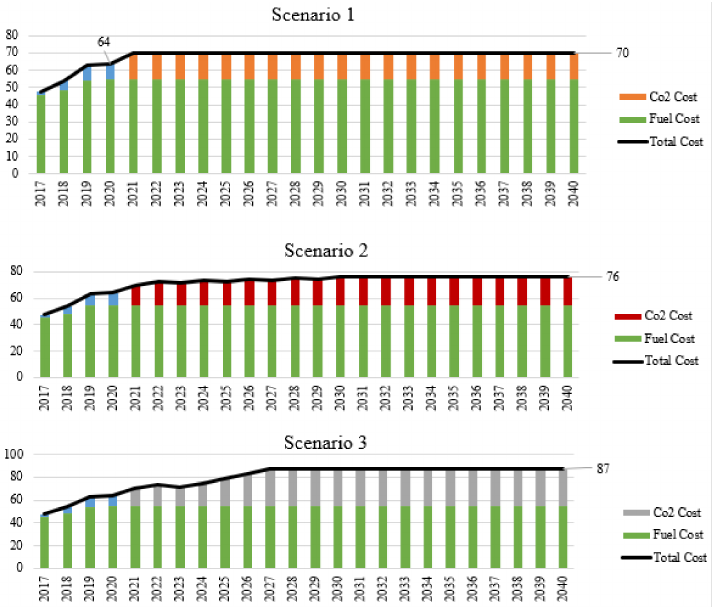
Figure A2. Estimation of average annual total cost of Natural Gas-fired Units ( € /MWh), (2017–2040), Source: Authors’